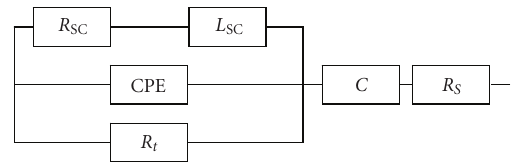
Figure 3: Equivalent electrical circuit of the metal/ transpassive film/solution